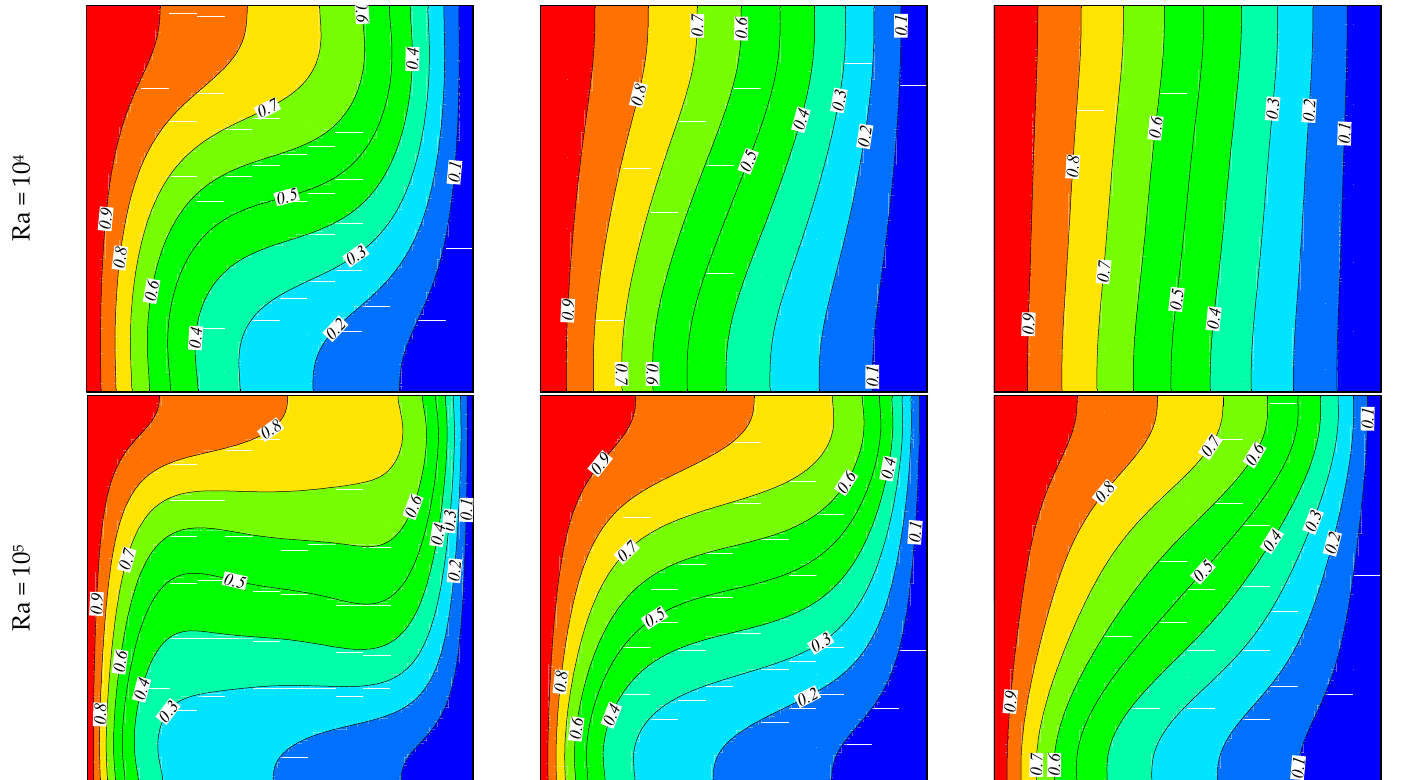
φ = 2%. Figure 3. Isotherm contours for different values of Rayleigh and Hartmann numbers when N = 1, m = 3, and φ =